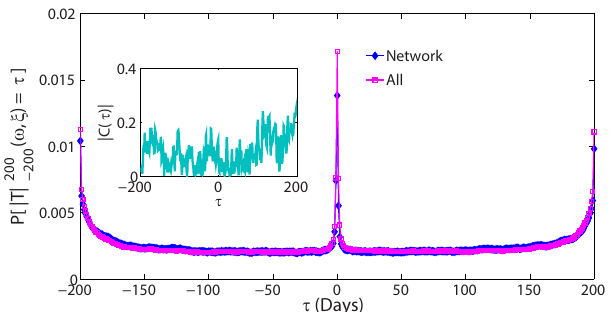
−8 (ω(t),ξ(t)) (ω(t),ξ(t)) and T 8 − (ω(t),ξ(t)) (in- Figure 2. Distribution of | T | 8 − 200 8 8 set), where ω(t) and ξ(t) have long-range autocorrelations: β ξ and β ω are the exponents of the power spectra of ξ(t) and ω(t) respec- tively. Since the time series are stationary, C(τ,t) = C(τ) . We can (ω,ξ) over all see that as β gets larger, increasing the persistence in the time se- 200 ries, the bias also increases. This occurs despite ξ(t) and ω(t) hav- ing Gaussian distributions centred at zero. Fixed parameters are: (cid:127) = 16, with N = 2 21